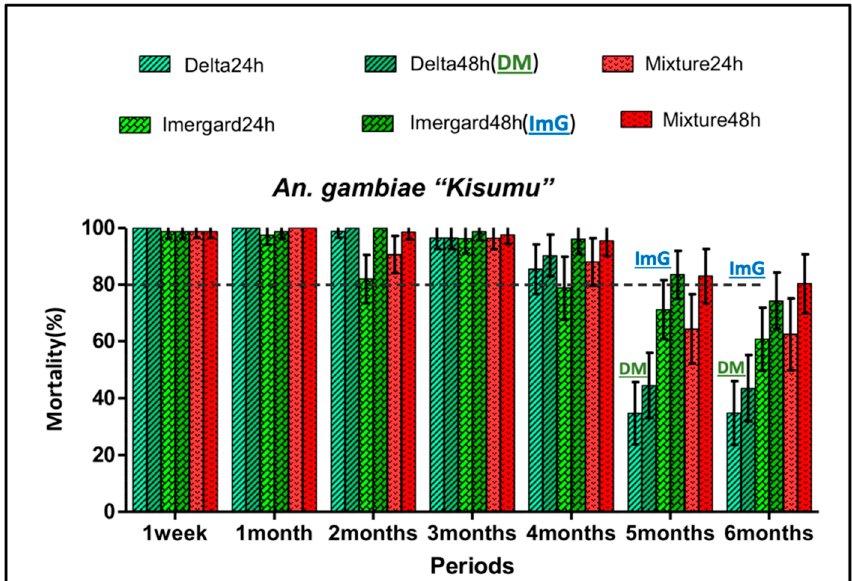
Figure 4. Residual mortality of Imergard TM WP, deltamethrin, and their mixture following cone bioassays with laboratory susceptible Anopheles gambiae “Kisumu” strain in experimental huts in Cove, Benin. For each treatment, mortality was recorded at 24 and 48 h after a 30 min exposure to the walls. Error bars represent 95% confidence intervals. Delta and DM = Deltamethrin; ImG = Imergard TM WP; Mixture = Deltamethrin + Imergard TM WP. The gray dotted line indicates the 80% threshold requirement of the WHO for residual activity.